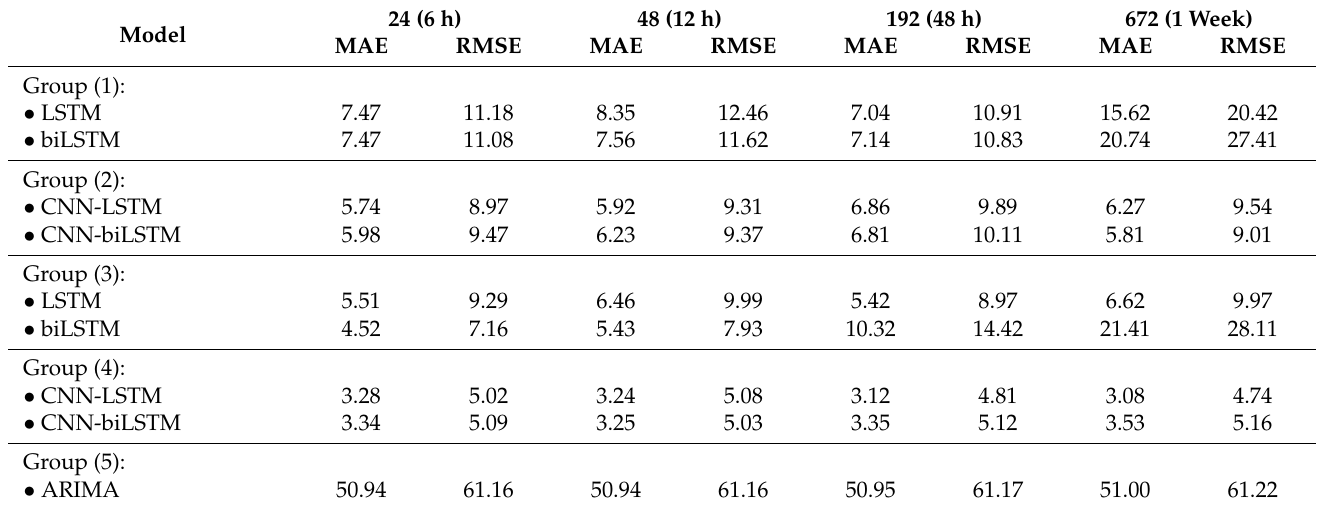
Table 2. Evaluation metrics of prediction on test data considering different sliding